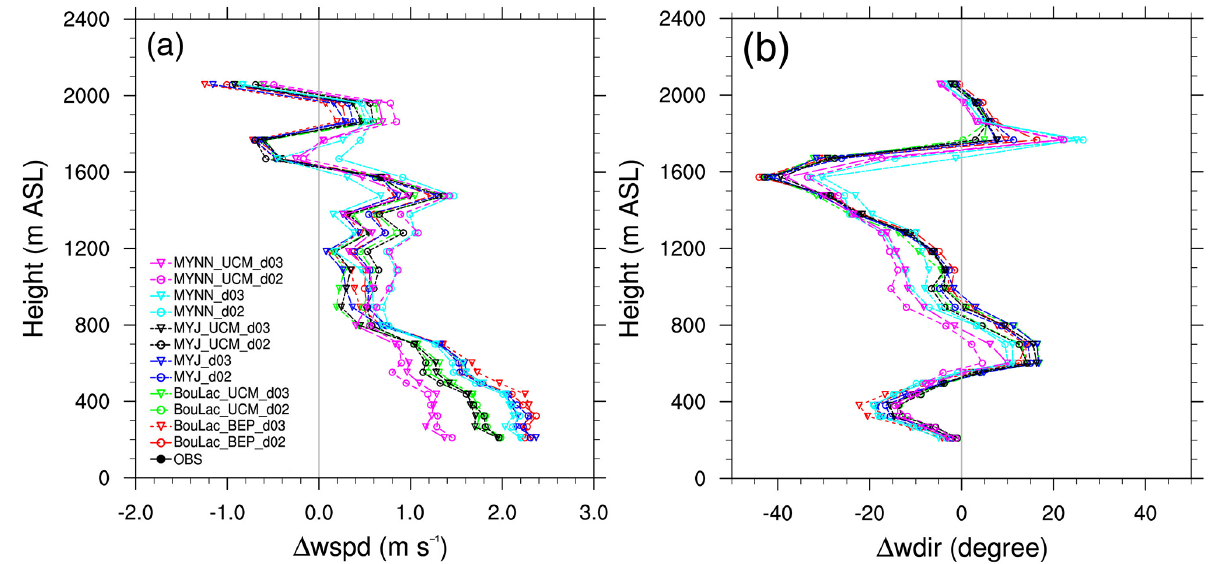
Figure 5. Average differences of wind profiles between the simulations and observations (model–wind radar profiler) at the Los Angeles International Airport (LAX). (a) The difference for wind speed (unit: ms − 1 ); (b) for wind direction (unit: ◦ ). Note that these results are for daytime 11:00–17:00PST only.